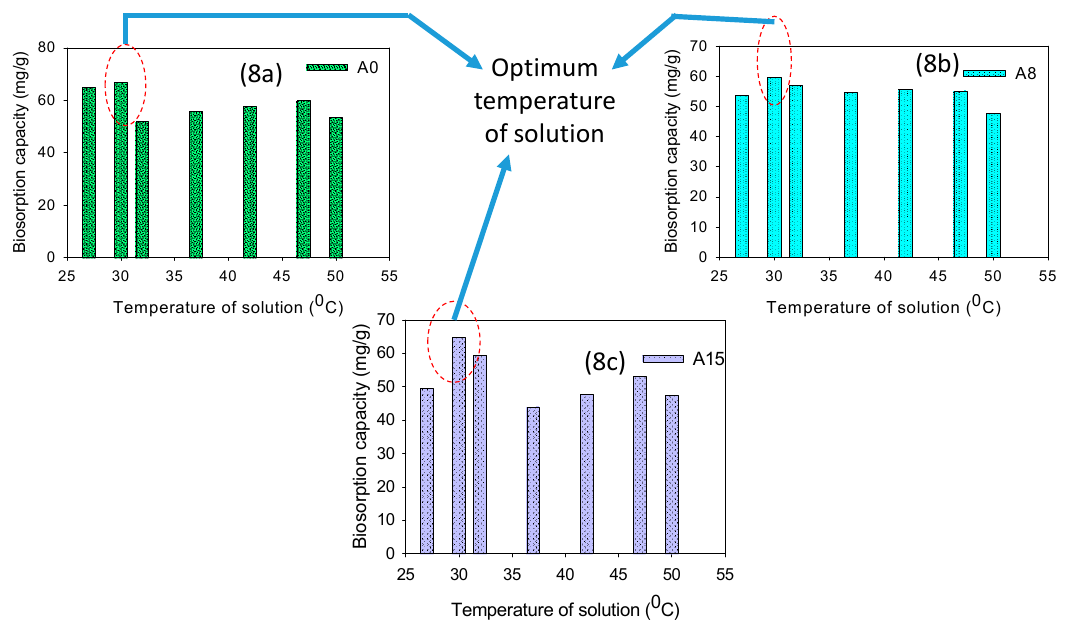
Figure 8. Effect of temperature of the solution on sorption efficiency of Cd 2+ onto dried biosorbent of Aphanothece sp. for ( a ) adsorbent A0 (CO 2 enrichment of 0.04%), ( b ) adsorbent A8 (CO 2 enrichment of 8%) and ( c ) adsorbent A15 (CO 2 enrichment of 15%) (W 0 = 0.1 g/L, C 0 = 7.99 mg/L, t contact = 60 min).